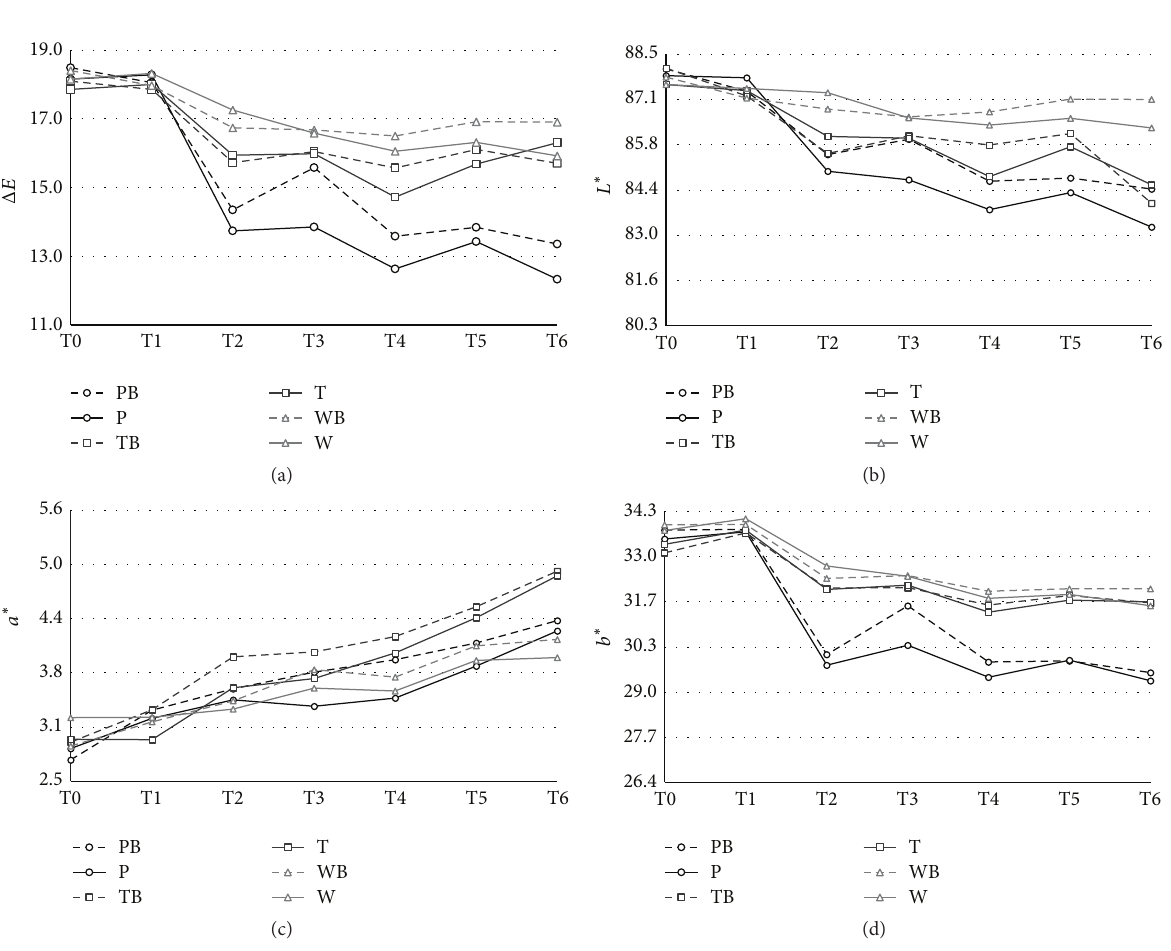
Figure1:(a) Δ𝐸 valuesafterstainingandbleachingwith35%hydrogenperoxide.(b) 𝐿 ∗ valuesafterstainingandbleachingwith35%hydrogen peroxide. (c) 𝑎 ∗ values after staining and bleaching with 35% hydrogen peroxide. (d) 𝑏 ∗ values after staining and bleaching with 35% hydrogen peroxide . PB: purple corn + bleaching; P: purple corn; TP: green tea + bleaching; T: green tea; WB: distilled water + bleaching; W: